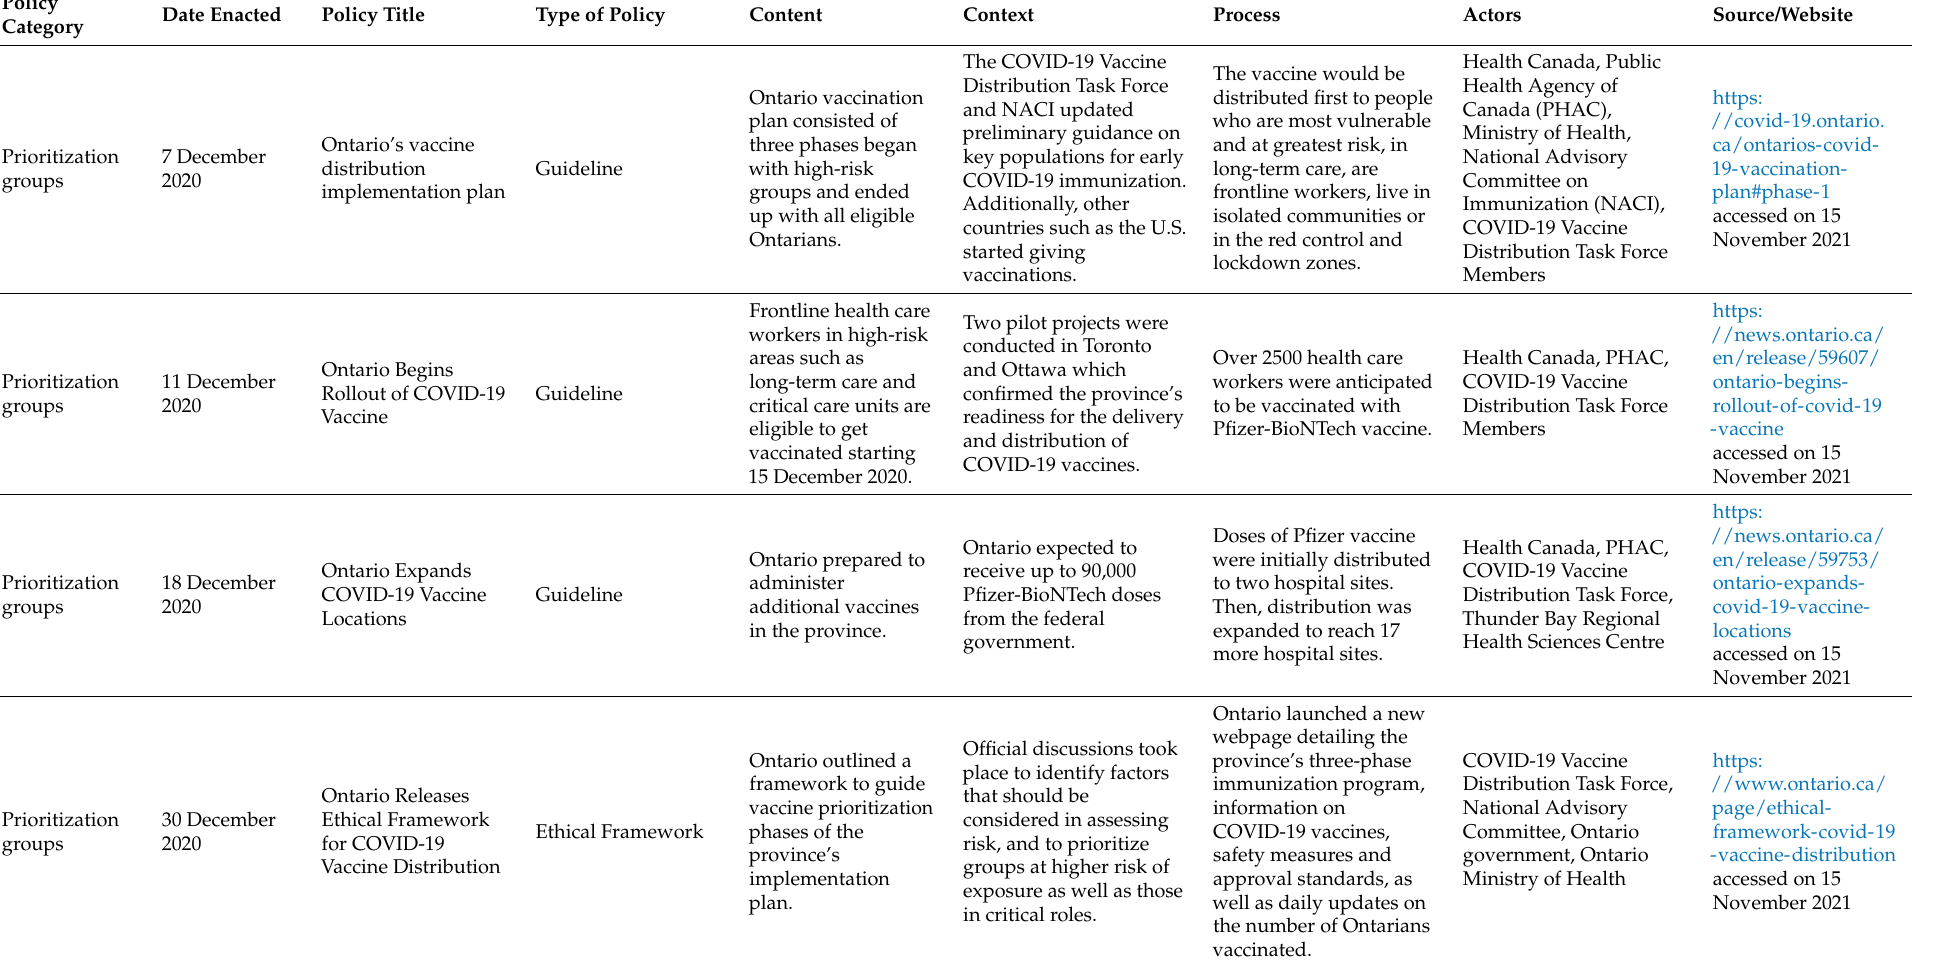
Table 1. Summary of COVID-19 vaccination policies in Canada using the policy triangle framework